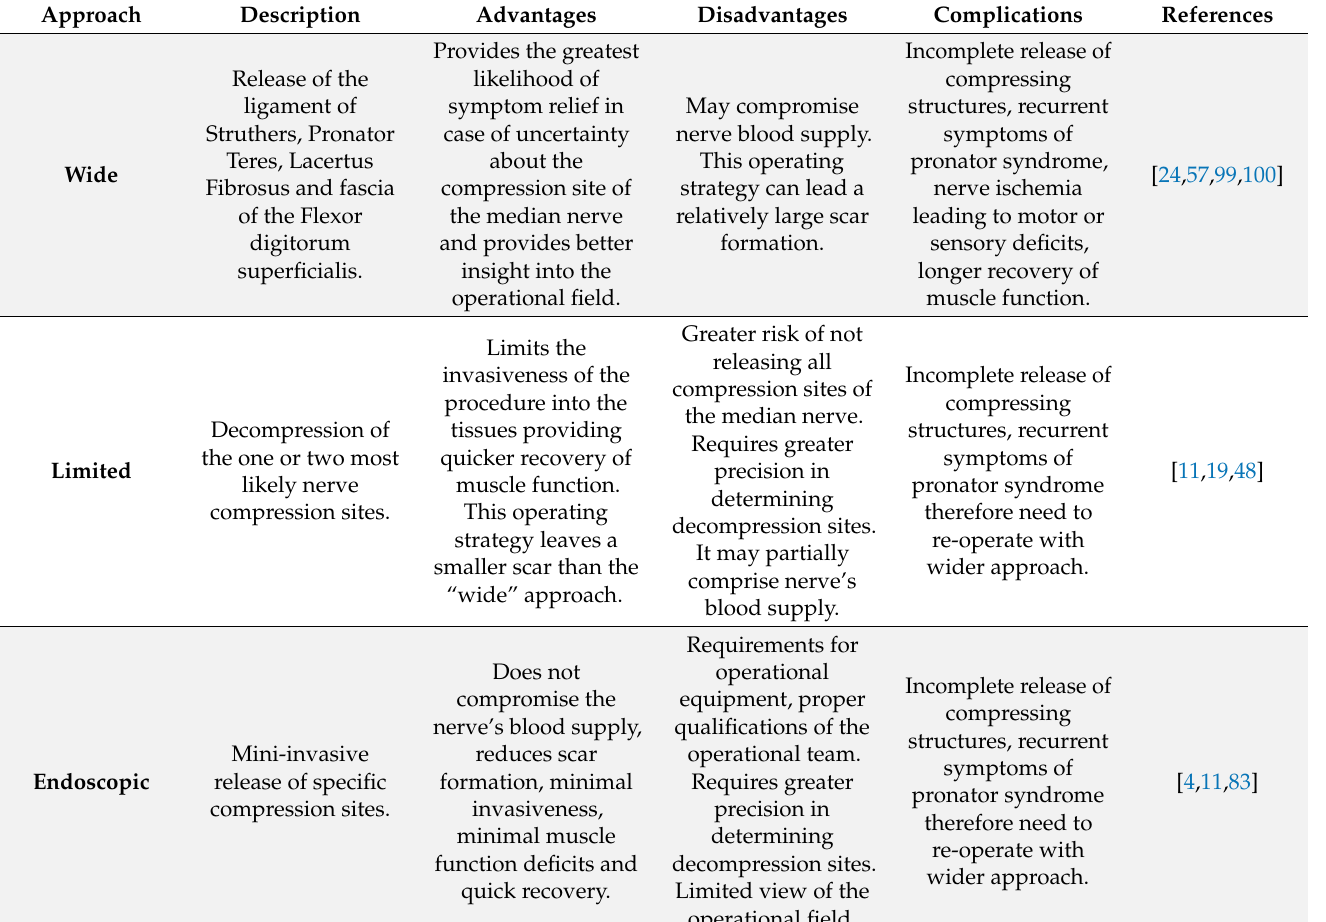
Table 3. Comparison of advantages, disadvantages, and potential complications for surgical treatment